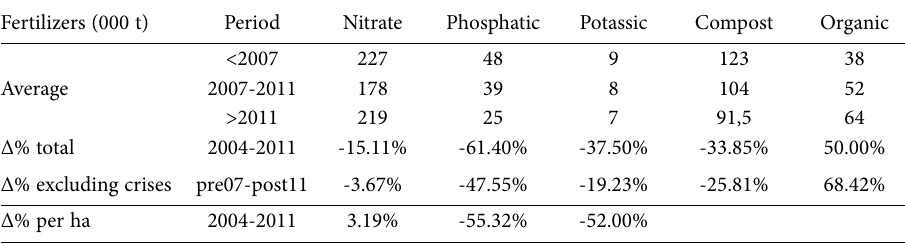
Table 1. Evolution of fertilizer consumption in the Emilia-Romagna region. Fertilizers (000 t) Period Nitrate Phosphatic Potassic Compost